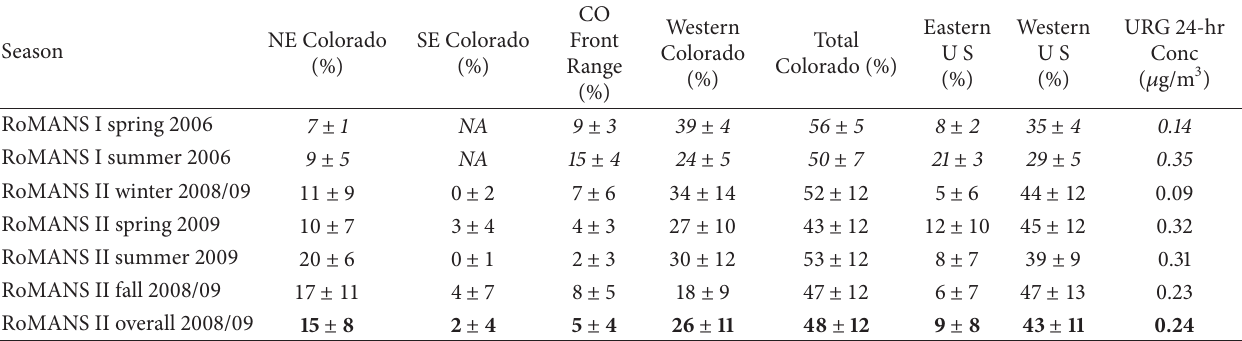
Table 4: Mean measured 24-hour ammonia concentrations by season in the far right column and percent attributions ± standard deviations byTrMBanalysisforthe2006RoMANSI(italicfont)and2009RoMANSIIstudies.Thevaluesinthebottomrow(boldfont)areconcentration weighted means of the four 2008/09 seasons.The RoMANS II results are composite results from 360 TrMB trials for each season using concentrations for the correct time, but allowing all other parameters shown in Table 3 to vary. See Table 5 and Figure 11 for